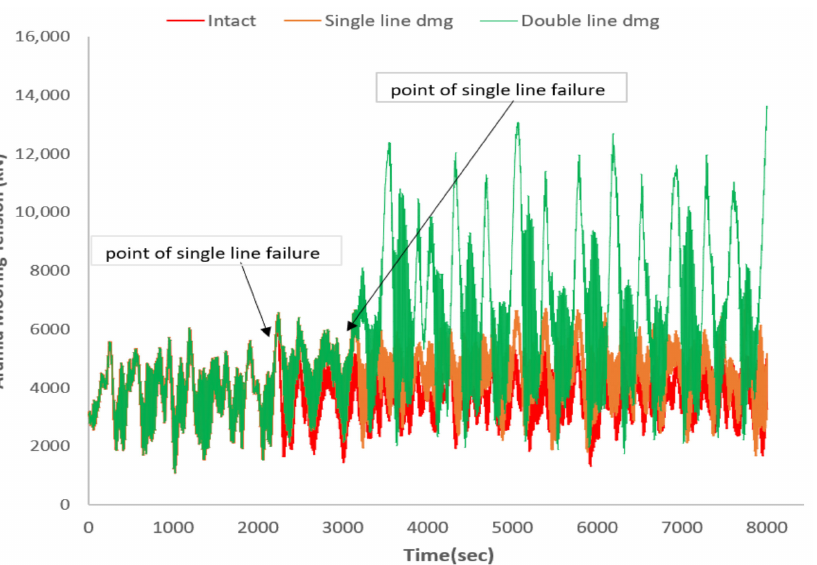
Figure 11. Comparison of Aramid representative mooring line (line 7) in intact and damaged conditions.